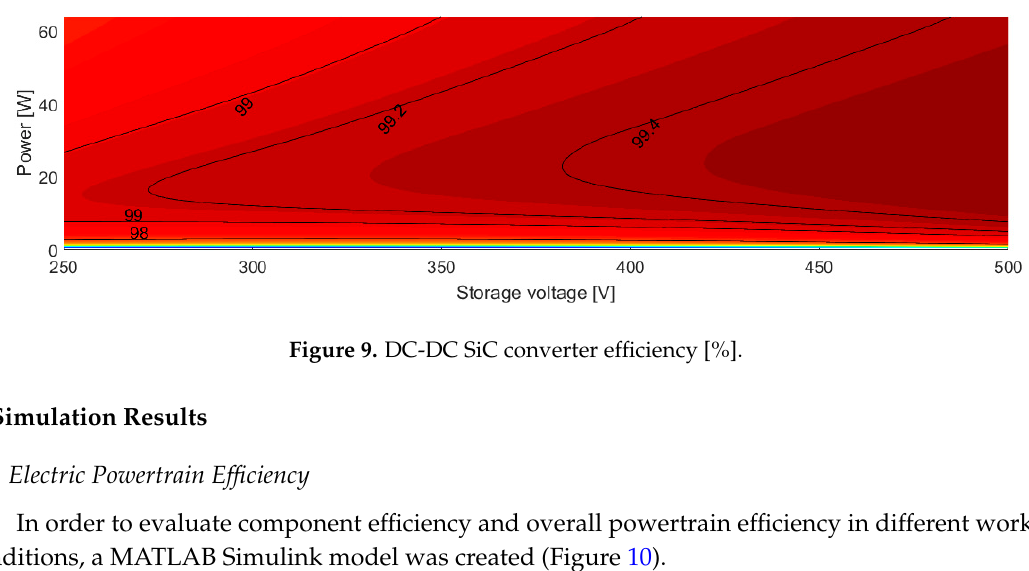
Figure 8. DC-DC Si converter efficiency [%].